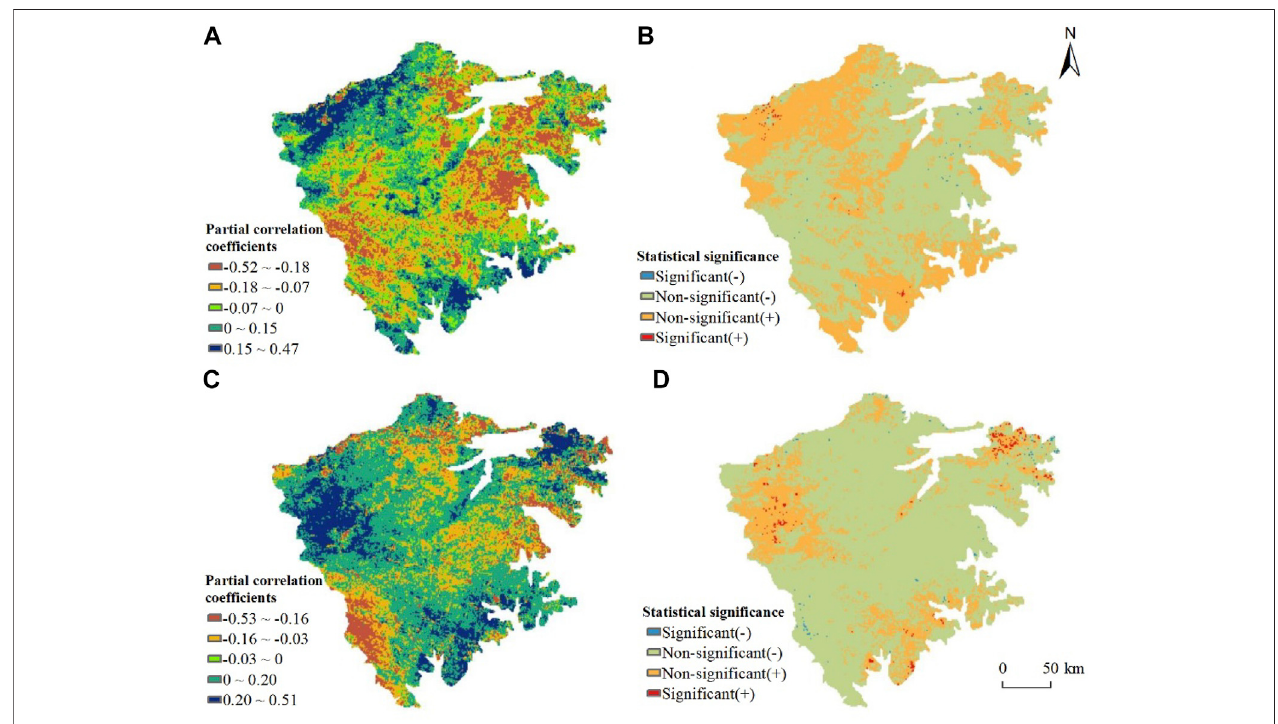
FIGURE 9 | Partial correlation coef fi cients between NDVI and temperature (A) , precipitation (C) ; and statistical signi fi cance of the correlations between NDVI and temperature (B) , precipitation (D) .